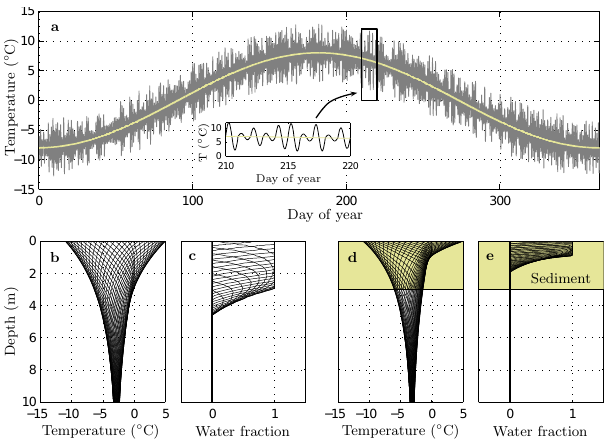
Figure 3. Panel (a) : the temperature curve used as the surface boundary condition for the heat equation. The curve is a sinusoidal annual temperature oscillation of amplitude d T a = 8 ◦ C. Superim- posed on this curve are diurnal sinusoidal variations of random amplitude between 0 and 4 ◦ C. The inset shows details of the two superimposed variations. Panel (b) : modelled temperature profiles shown at weekly intervals throughout a year. The diurnal oscilla- tions are in this case omitted for clarity. Latent heat exchange stalls the propagation of temperature variations, and this leads to a kink in the temperature profiles around 0 ◦ C. Panel (c) : the correspond- ing weekly evolution of water fraction along the profile. A water fraction of 0 corresponds to frozen conditions and 1 to completely thawed sediment or bedrock. The partially thawed part of the pro- file (water content between 0 and 1) extends deeper than the 0 ◦ C isotherm because ice starts to thaw at − 1 ◦ C. Panels ( d and e ): as for ( b ) and ( c ) but with a sediment cover (yellow fill). Note that the effects of the latent heat are more pronounced because the sedi- ment has higher porosity than bedrock. The latent heat dampens the propagation of temperature variations into the subsurface and the freeze–thaw events are shallow in the case of thick sediment